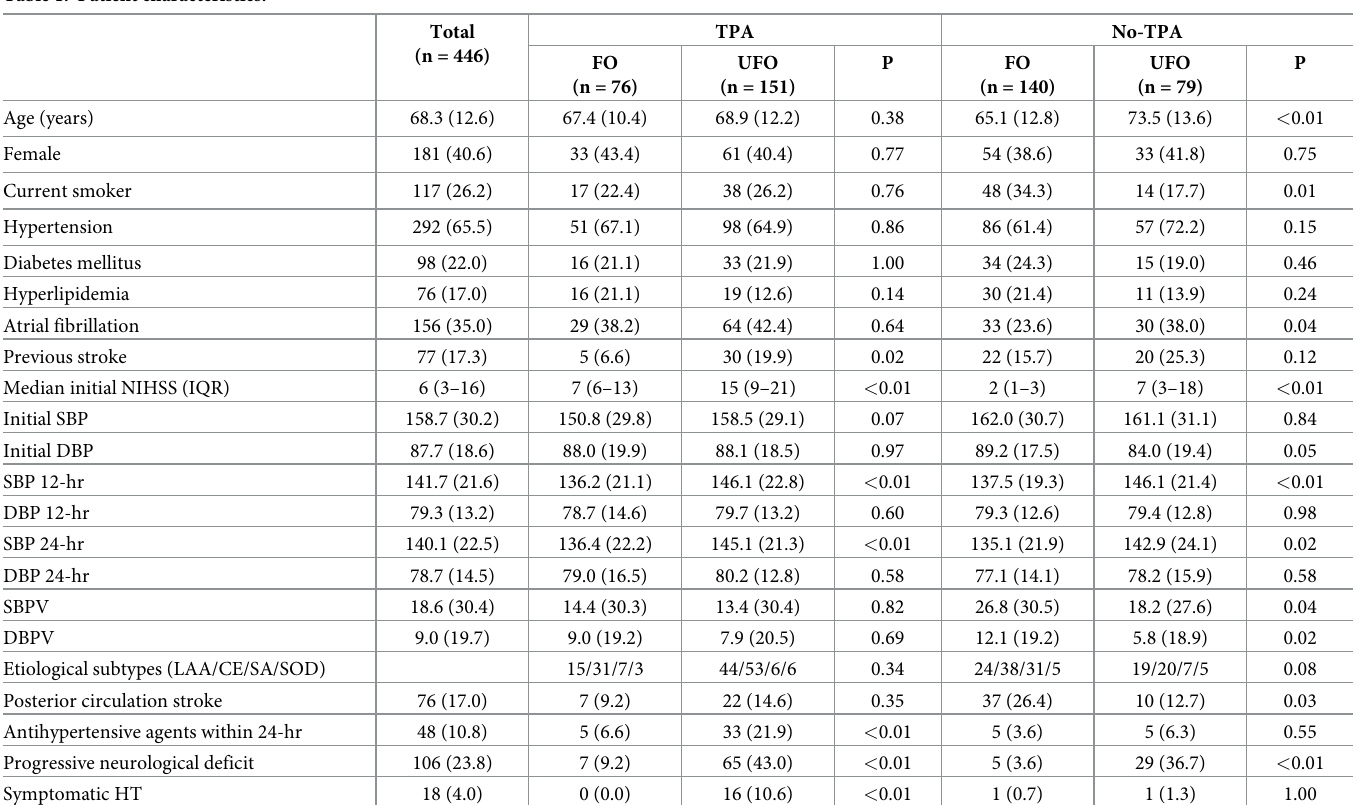
Table 1. Patient